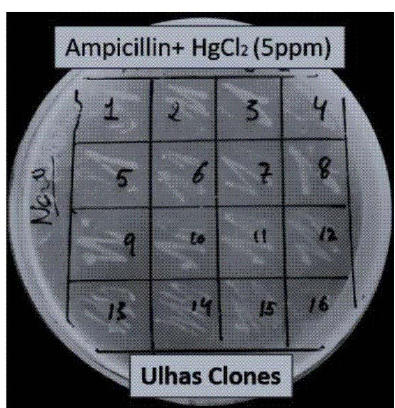
Fig. 2. Clones (containing mer operon) from Ulhas soil showing growth on 5ppm Hg table 2. CFU count of Ulhas clones at different Hg concentration S.